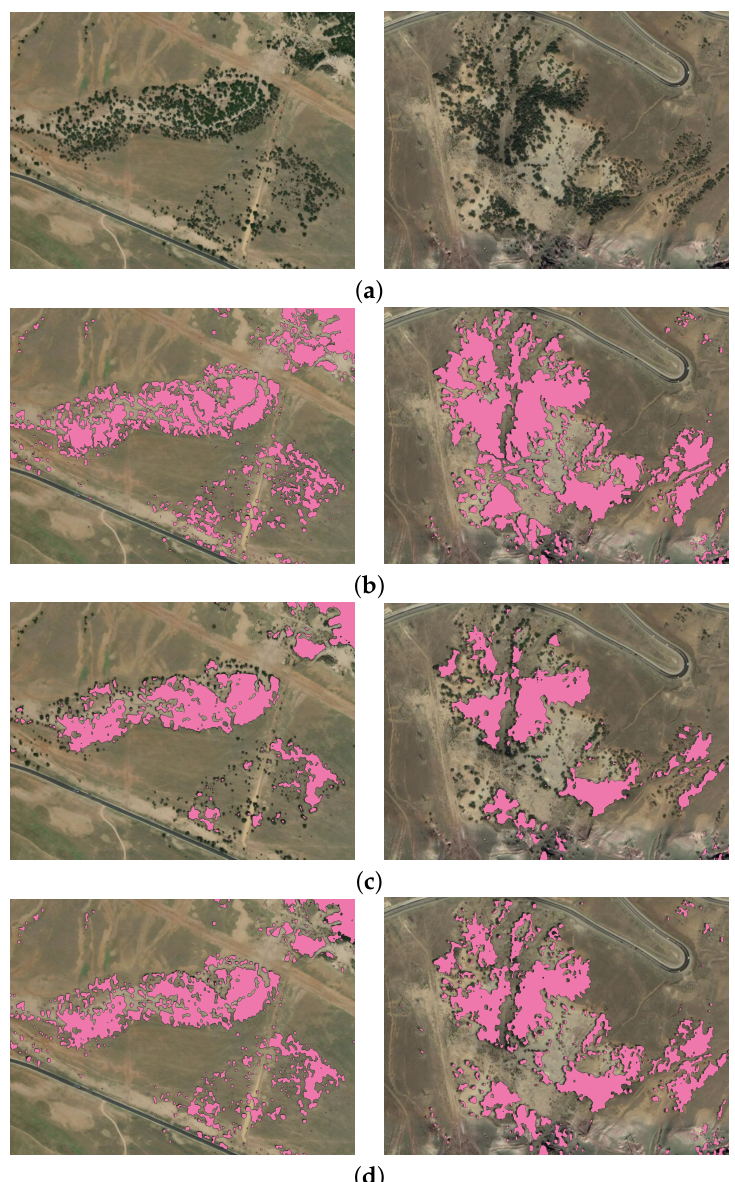
Figure 4. Forest segmentation results for Republic of Tatarstan test territories: ( a ) input image; ( b ) ground truth; ( c ) small dataset fine-tuned without OBA; ( d ) small dataset fine-tuned with